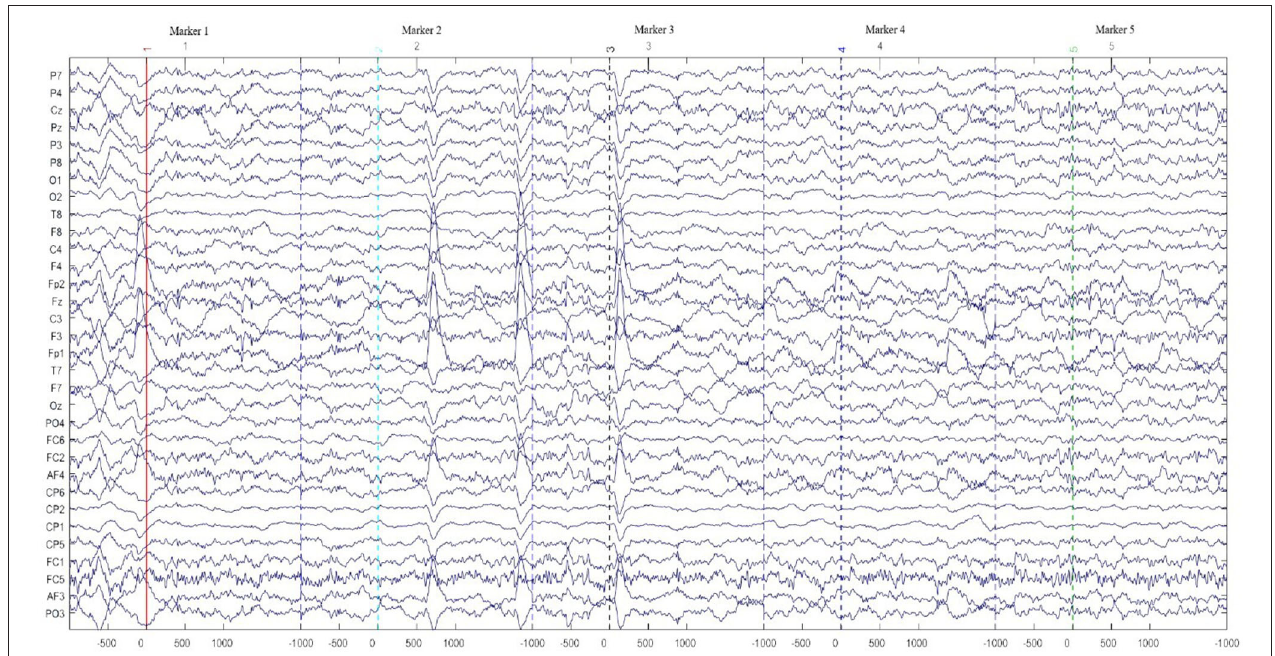
FIGURE 4 | Sample electroencephalogram (EEG) waveforms after removing